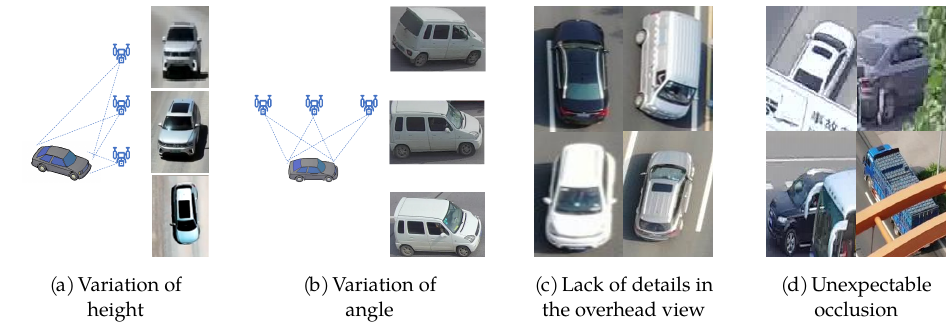
Figure 2. The problem of viewpoint in vehicle ReID on UAV